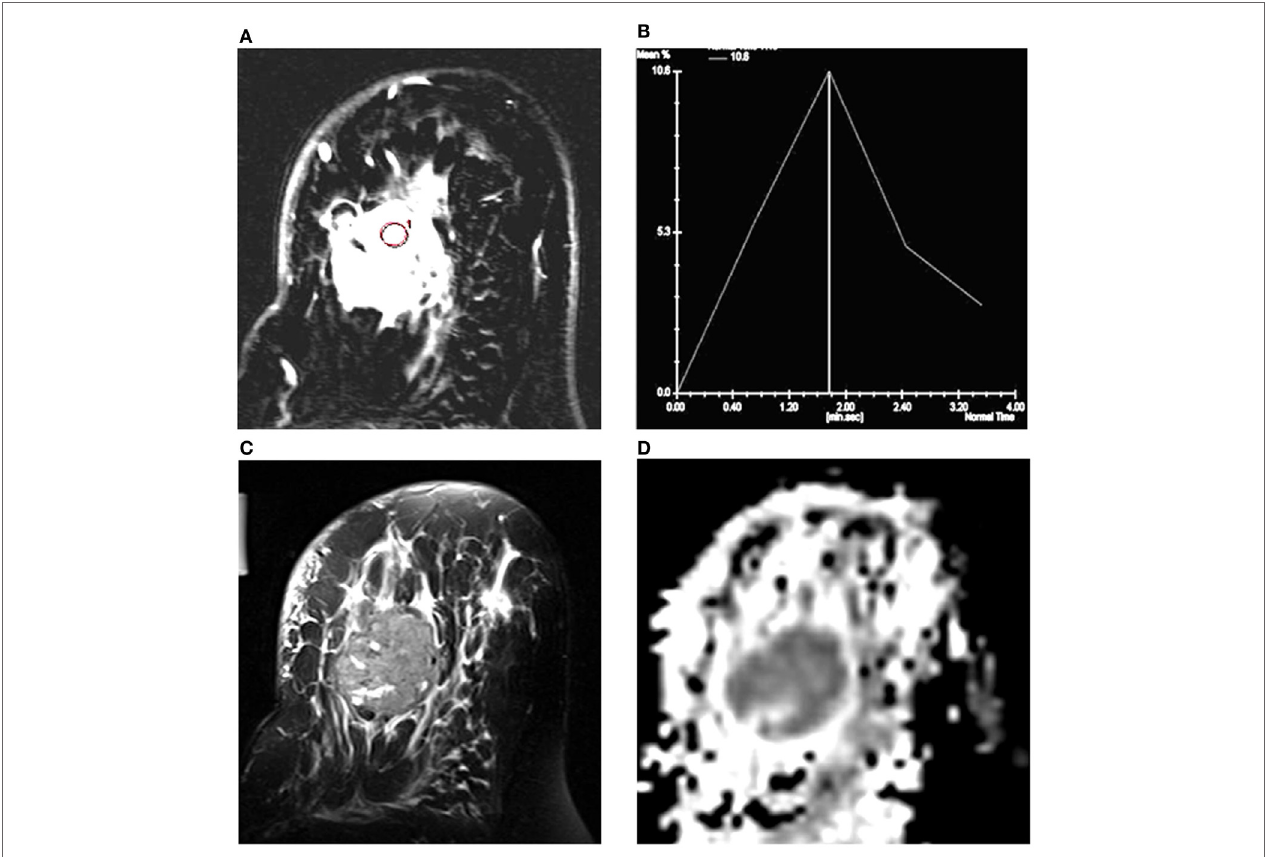
FigUre 2 | (a) T1-axial DCEMR image of a 56-year-old patient with infiltrating ductal carcinoma (IDC); (B) Type III dynamic curve with washout pattern from the ROI shown in the lesion; (c) T2-weighted fat-saturated axial image; and (D) the ADC map of the same